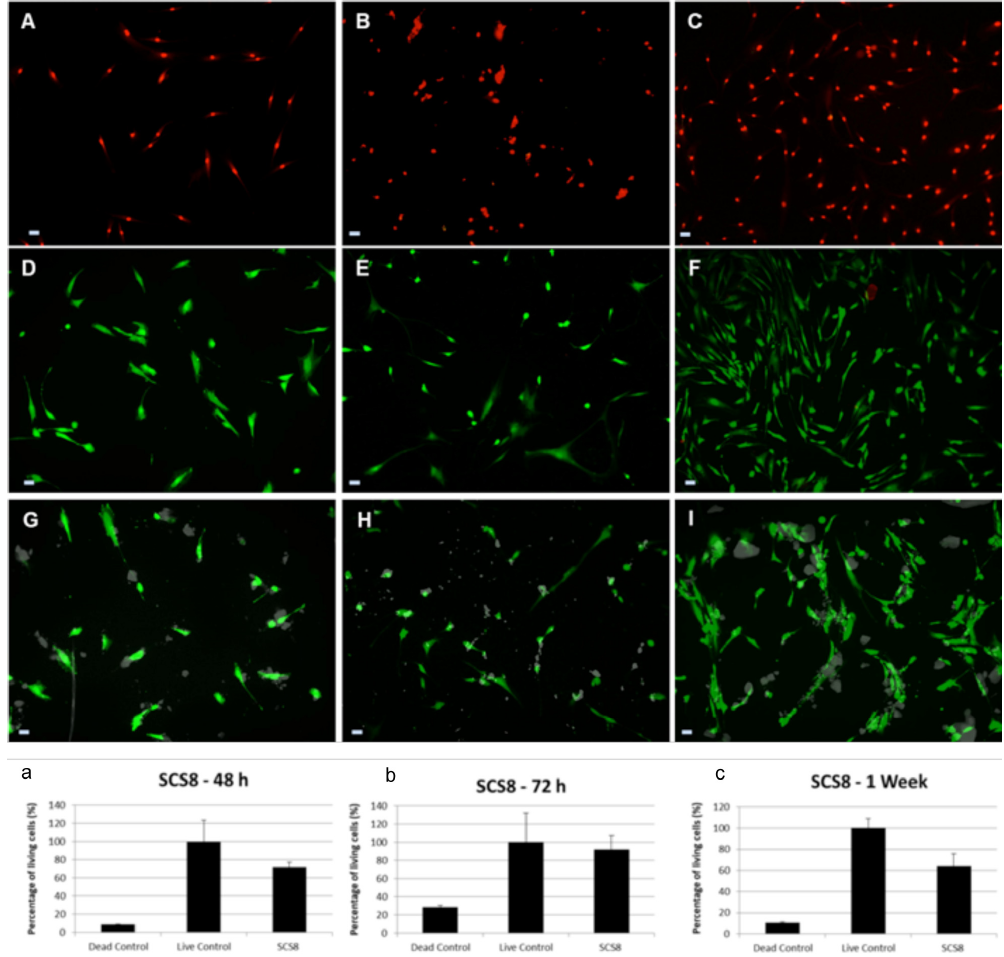
Figure 11. Live / dead staining of HOB ® osteoblasts growing on: ( A ) Glass, 48 h in culture. Negative control obtained after 70% ethanol exposure for 30 min before staining; ( B ) Glass, 72 h in culture, negative control